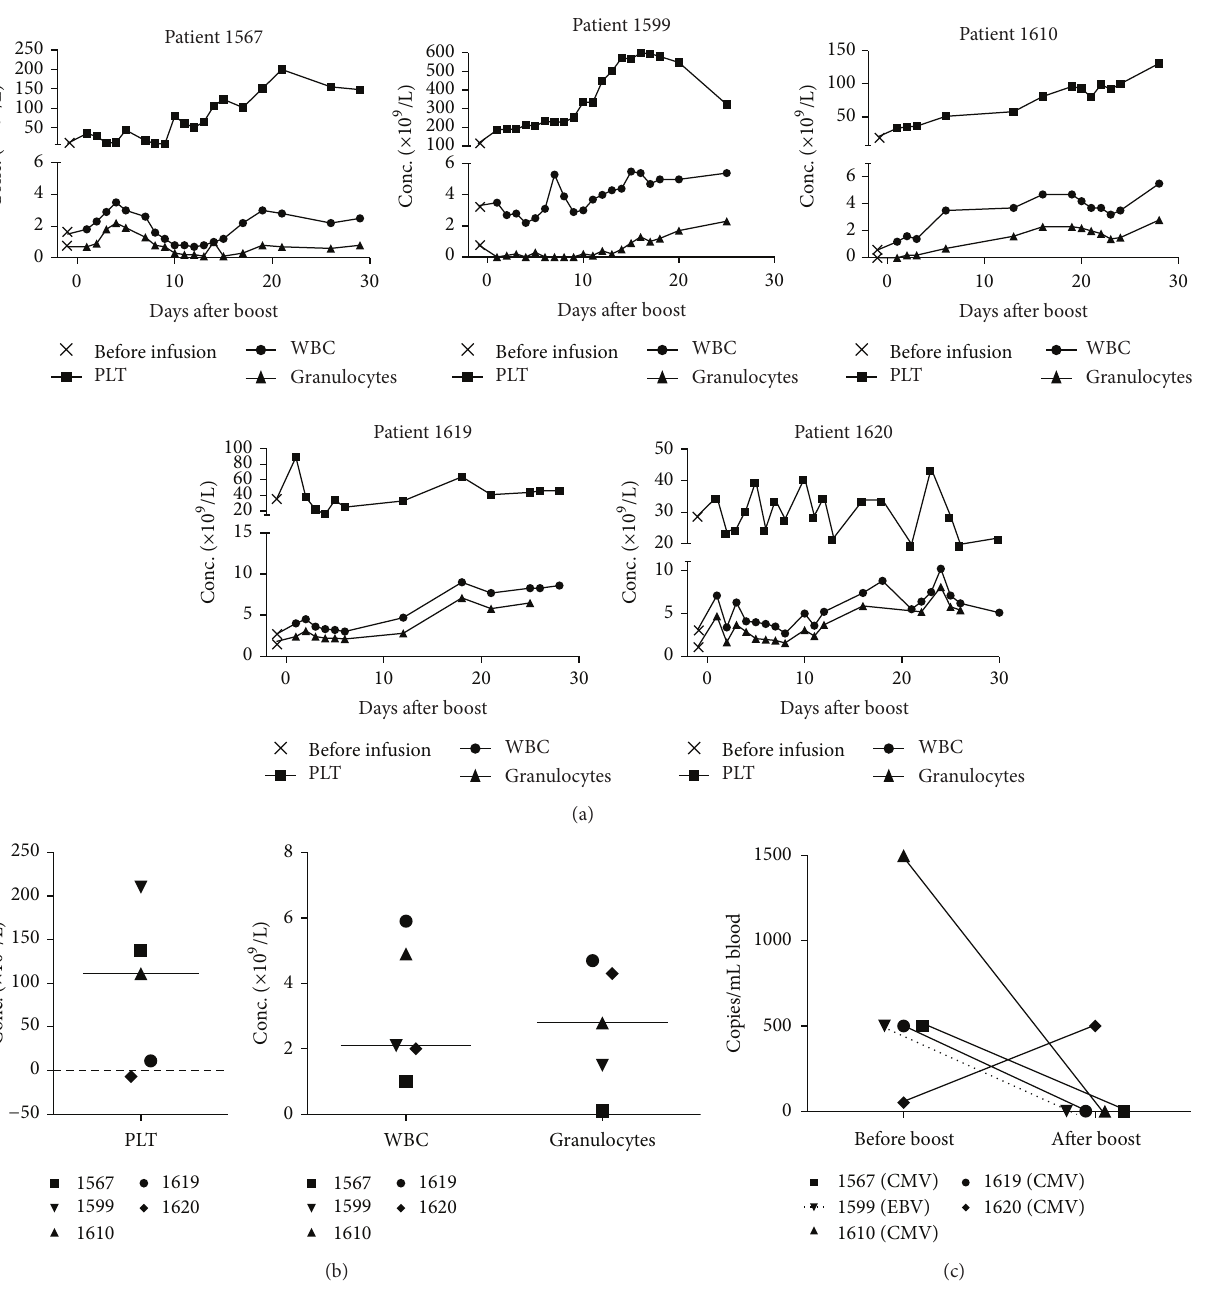
Figure 3: Clinical parameters up to 30 days after infusion of 𝛼𝛽 -depleted graft. (a) Clinical parameters of platelets (PLT), white blood cells (WBC), and granulocytes of each patient at different time points up to 30 days after infusion. (b) The change in PLT, WBC, and granulocyte concentration (10 9 /L) in the individual patients. Lines indicate the median change in concentration. (c) Cytomegalovirus (CMV) copies per mL blood in four patients andEpstein Barr virus (EBV) copies per mL blood (in patient 1599, dashed line) before and 14–30 days after booster